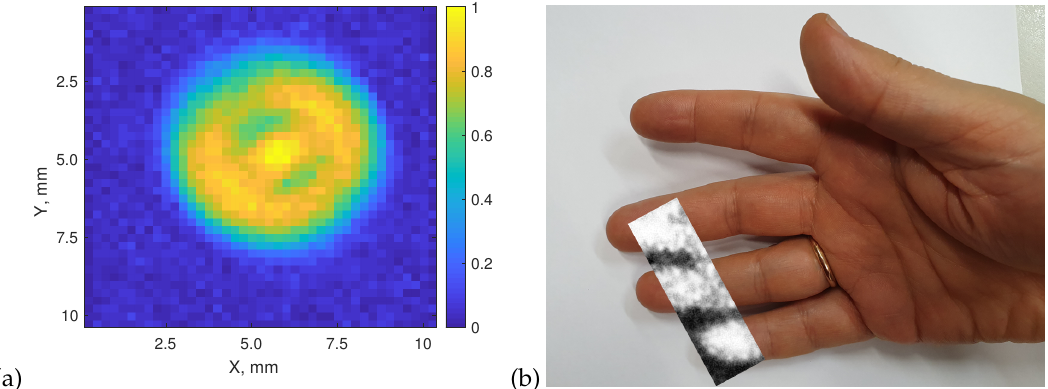
Figure 8. Thermal images recorded with the broadband Si CMOS TeraFET detector at room temperature. ( a ) image of the thermal emission pattern of the heated ceramic source; ( b ) image of sections of three fingers of a human hand. The image is superimposed on a photograph of the hand. In both cases, mechanical chopping of the thermal radiation was